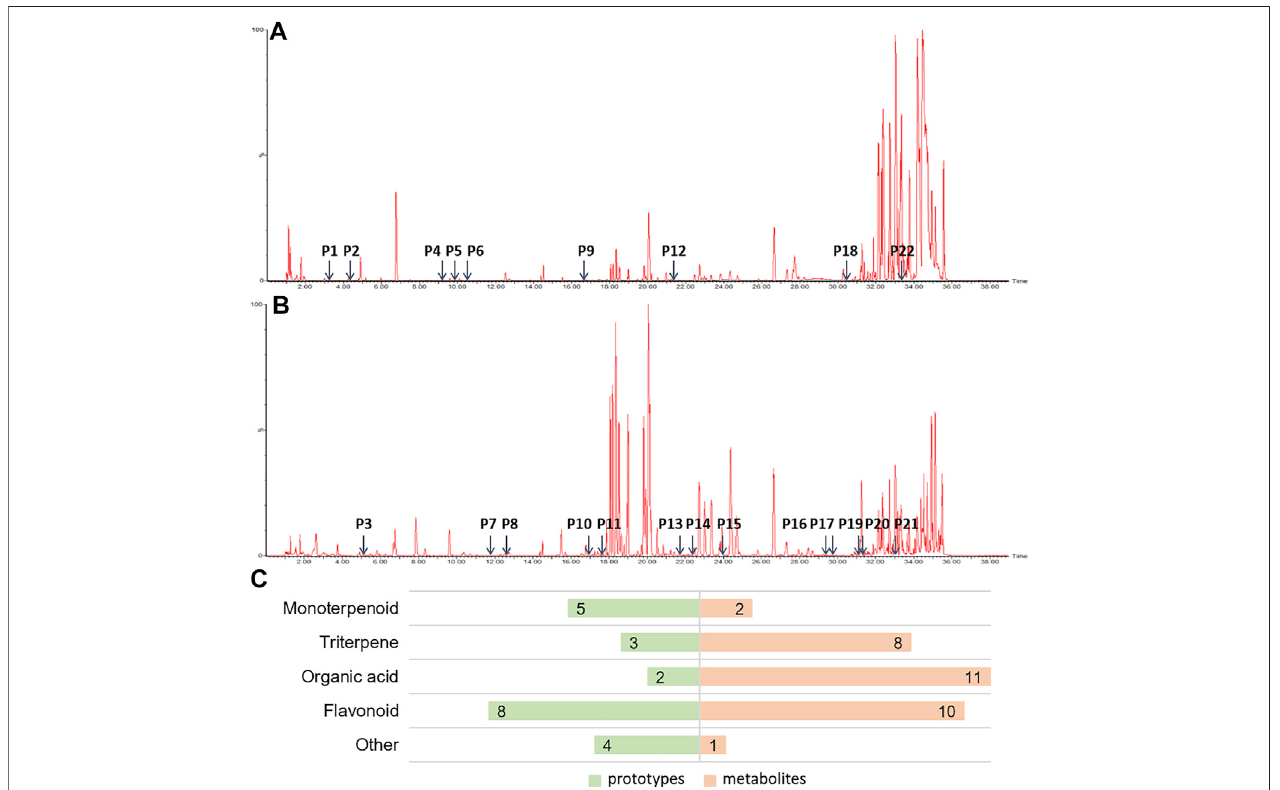
FIGURE 3 | The prototypes and their metabolites in the plasma of rats after intragastric administration of HHXYT. Total ion chromatograms of rat plasma samples after intragastricadministrationofHHXYTandthedistribution of22prototypes,positivemode (A) andnegativemode (B) . (C) Categoriesofprototypesandmetabolites.